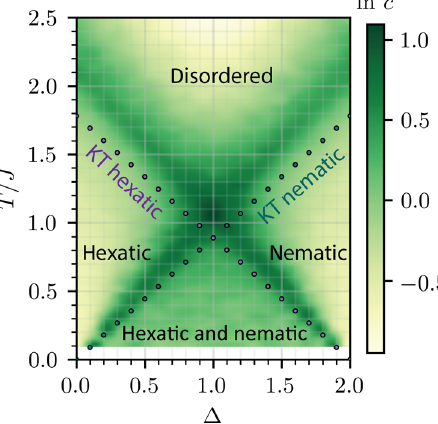
FIG. 3. Numerical phase diagram of the uncoupled λ ¼ 0 hexatic-nematic XY model in Eq. (3.1) as a function of the temperature T and ratio of exchange couplings Δ ¼ J 2 =J obtained from classical Monte Carlo simulations. Background color density denotes specific heat per site c at system size L ¼ 40 (see logarithmic color bar). We distinguish four different phases: (i) a disordered phase with purely short-range correla- tions, (ii) a hexatic phase with algebraic correlations of h cos ð θ i − θ j Þi ∼ j i − j j − η 6 ð T Þ , (iii) a nematic phase with algebraic correlations of h cos ð ϕ i − ϕ j Þi ∼ j i − j j − η 2 ð T Þ , and (iv) an ordered phase with algebraic correlations of both hexatic and nematic degrees of freedom. Here, h O i denotes the thermal average. The KT transition temperatures (purple and blue dots) are obtained from the universal stiffness jump criterion ρ ð p Þ ð T p; KT Þ ¼ 2 T = π for nematic p ¼ 2 and hexatic p ¼ 6 variable extrapo- p; KT lated to infinite system